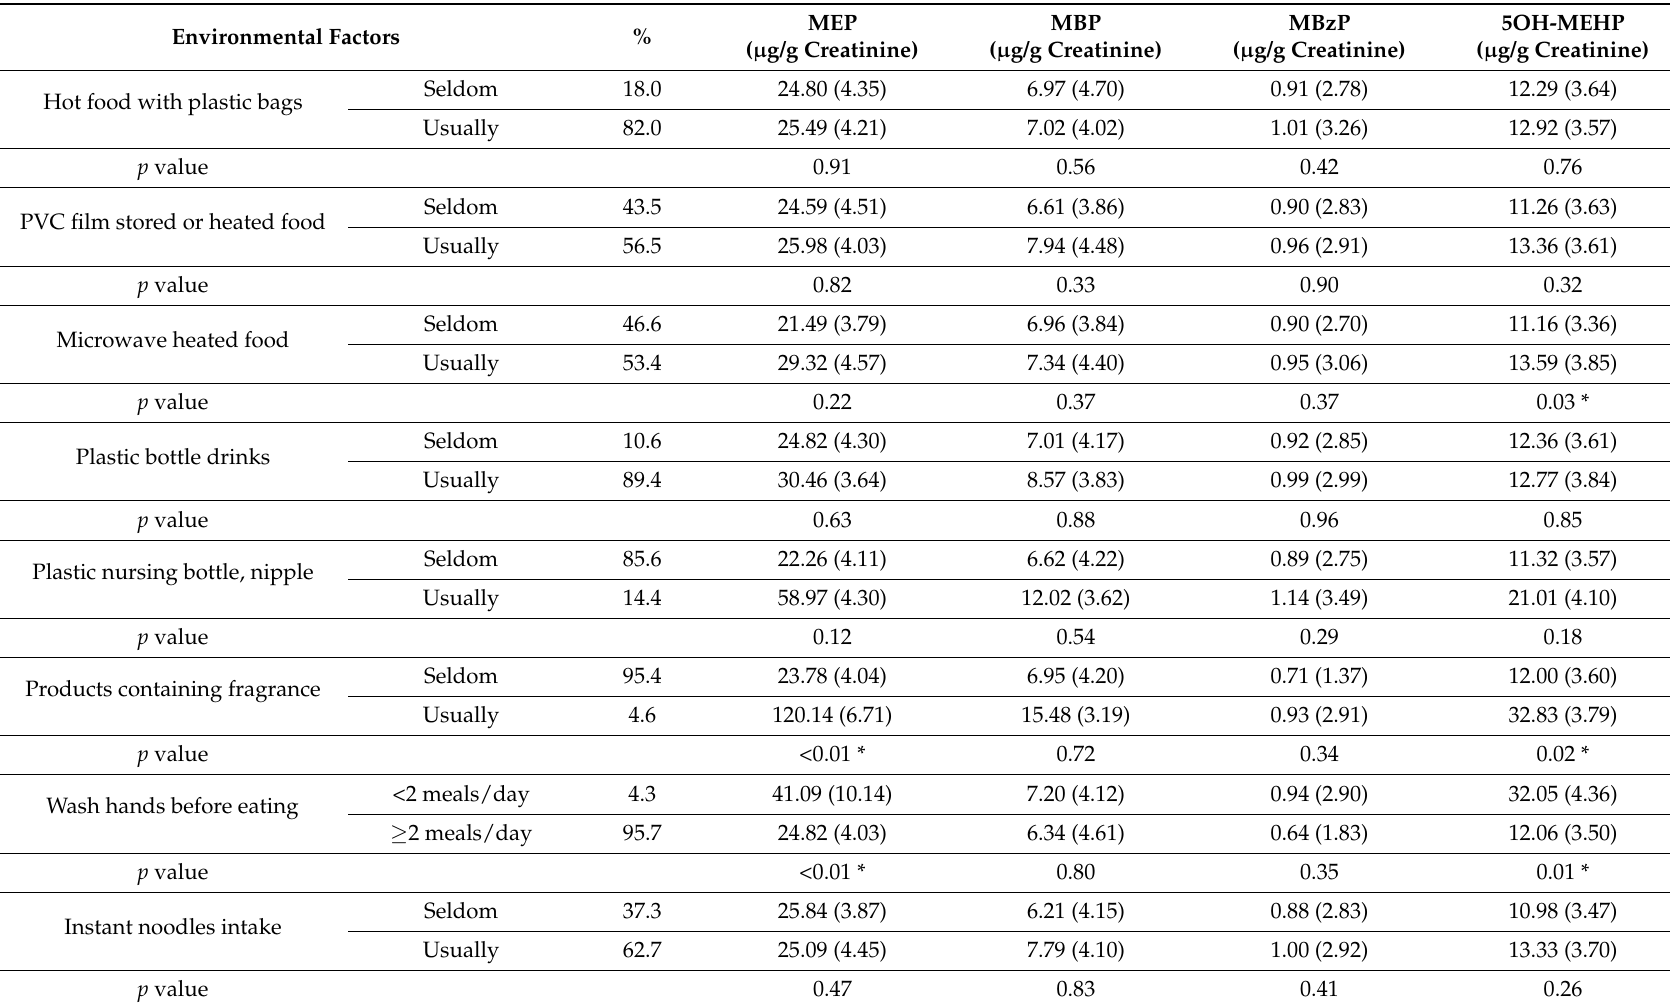
Table 4. Environmental factors of the study population in terms of geometric means (s.e.) of urine phthalate metabolites concentrations in 2013 ( n = 200). Environmental